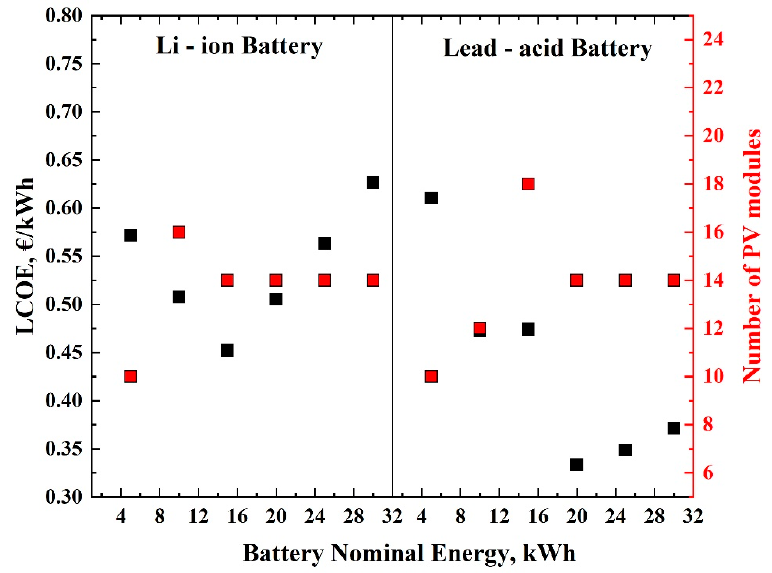
Figure 10. In this marker chart, six simulation instances per EES technology are presented and their calculated LCOEs are directly compared.